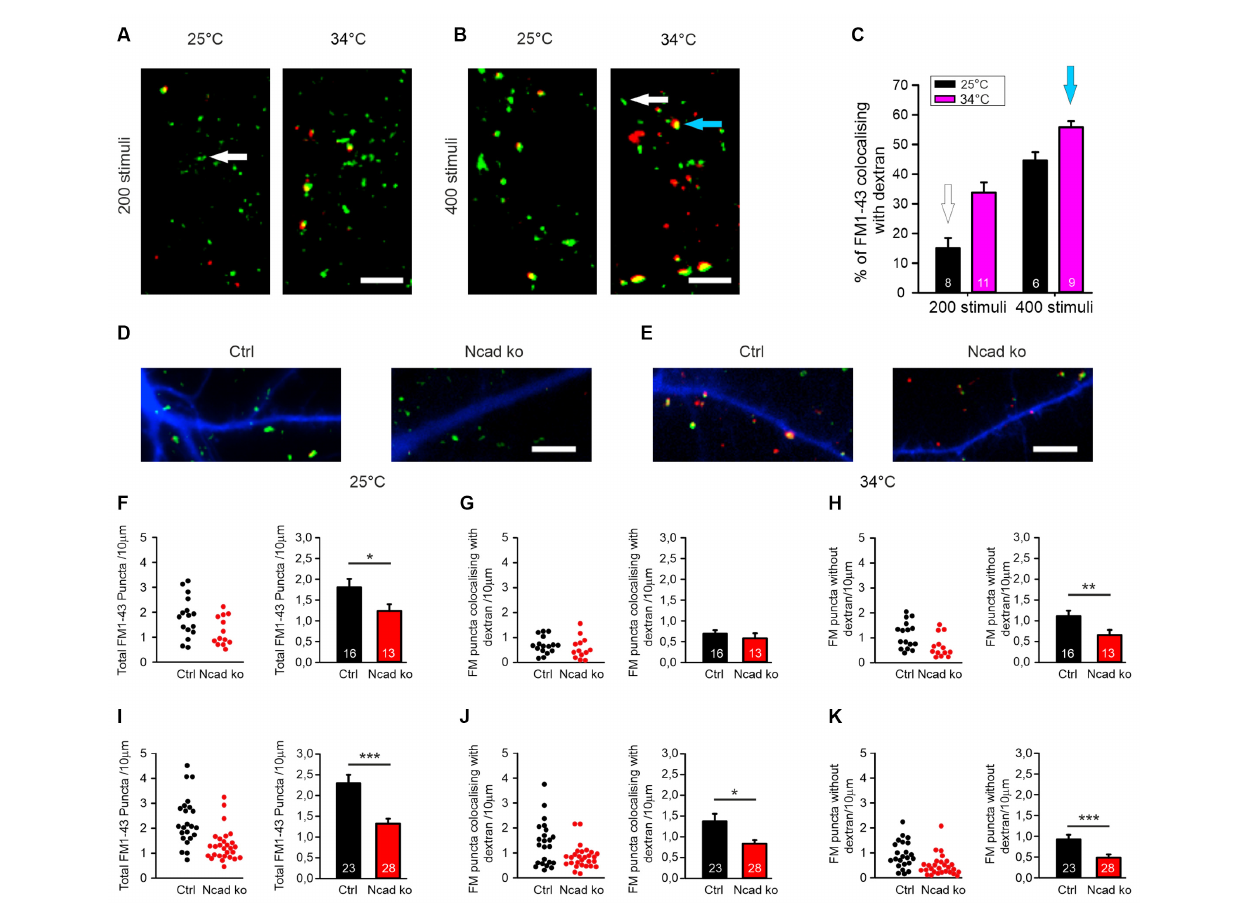
FIGURE 3 | Knockout of N-cadherin resulted in impairment of different modes of endocytosis at near physiological temperature (34 ◦ C). (A–C) Experimental paradigm to distinguish between individual vesicle endocytosis and bulk endocytosis. (A) Representative overlay images showing FM1–43 (green puncta) and TMR-dextran (red puncta) uptake induced by 200 stimuli (at 20 Hz) in cortical neurons in mass culture at 25 ◦ C ( left ) and at 34 ◦ C ( right ). The White arrow indicates a typical synaptic punctum with only FM1–43 uptake. Scale bar: 5 µ m. (B) Example overlay images showing FM1–43 (green puncta) and TMR-dextran (red puncta) uptake induced by 400 stimuli (at 20 Hz) in cortical neurons in mass culture at 25 ◦ C ( left ) and at 34 ◦ C ( right ). The Blue arrow indicates a typical punctum (yellow) showing co-uptake of both FM1–43 and TMR-dextran. Scale bar: 5 µ m. (C) Quantification of the percentage of FM1–43 positive puncta co-localizing with TMR-dextran uptake (black 25 ◦ C; magenta 34 ◦ C) with 200 ( n = 8/11) and 400 stimuli ( n = 6/9, n represents fields of view). (D,F–H) Cre mediated conditional (postsynaptic) knockout of N-cadherin resulted in reduced individual vesicle endocytosis at 25 ◦ C in cortical neurons at 14–15 DIV. Cortical neurons were sparsely co-transfected at 9 DIV with EBFP2 (to visualize dendrites) and CreEGFP. FM1–43 and TMR-dextran uptake was induced by electrical stimulation (200 stimuli at 20 Hz at 25 ◦ C). (D) Example overlay images of dendrites (blue) from transfected neurons with FM1–43 (green) and TMR-dextran puncta (red) overlayed. Scale bar: 5 µ m. (F) Quantification of the dendritic density of total FM1–43 labeled puncta in individual transfected neurons ( left ) and means ± SEM (black: control; red: N-cadherin knockout; n = 16/13 cells, right ). P = 0.043. (G) Quantification of the dendritic density of FM1–43 puncta co-localizing with TMR-dextran in individual neurons ( left ) and means ± SEM ( right ). Note that dextran uptake was very weak at this experimental condition (baseline uptake). (H) Quantification of the dendritic density of FM1–43 puncta not co-localizing with TMR-dextran in individual neurons ( left ) and means ± SEM ( right ). P = 0.013. (E,I–K) Postsynaptic knockout of N-cadherin by sparse Cre transfection (+EBFP2) resulted in a significant reduction in both, individual vesicle endocytosis and bulk endocytosis at near physiological temperature (34 ◦ C). Vesicle cycling was induced by 400 stimuli at 20 Hz. (E) Example overlay images of dendrites (blue) from transfected neurons with FM1–43 (green) and TMR-dextran puncta (red) overlayed. Scale bar: 5 µ m. (I) Quantification of the dendritic density of total FM1–43 puncta in individual neurons ( left ) and means ± SEM (black: control; red: N-cadherin knockout; n = 23/28 cells, right ). P < 0.001. (J) Quantification of the dendritic density of FM1–43 puncta co-localizing with TMR-dextran in individual neurons ( left ) and means ± SEM ( right ). P = 0.044. Note the reduction in TMR-dextran uptake in N-cadherin knockout neurons indicating impaired bulk endocytosis. (K) Quantification of the dendritic density of FM1–43 puncta not co-localizing with TMR-dextran in individual neurons ( left ) and means ± SEM ( right ). ns: non-significant, P = 0.001. * P < 0.05, ** P < 0.01, *** P < 0.001, Student’s t -test (F,G) . Whenever the normality test failed Mann-Whitney’s test on ranks was performed (H–K)